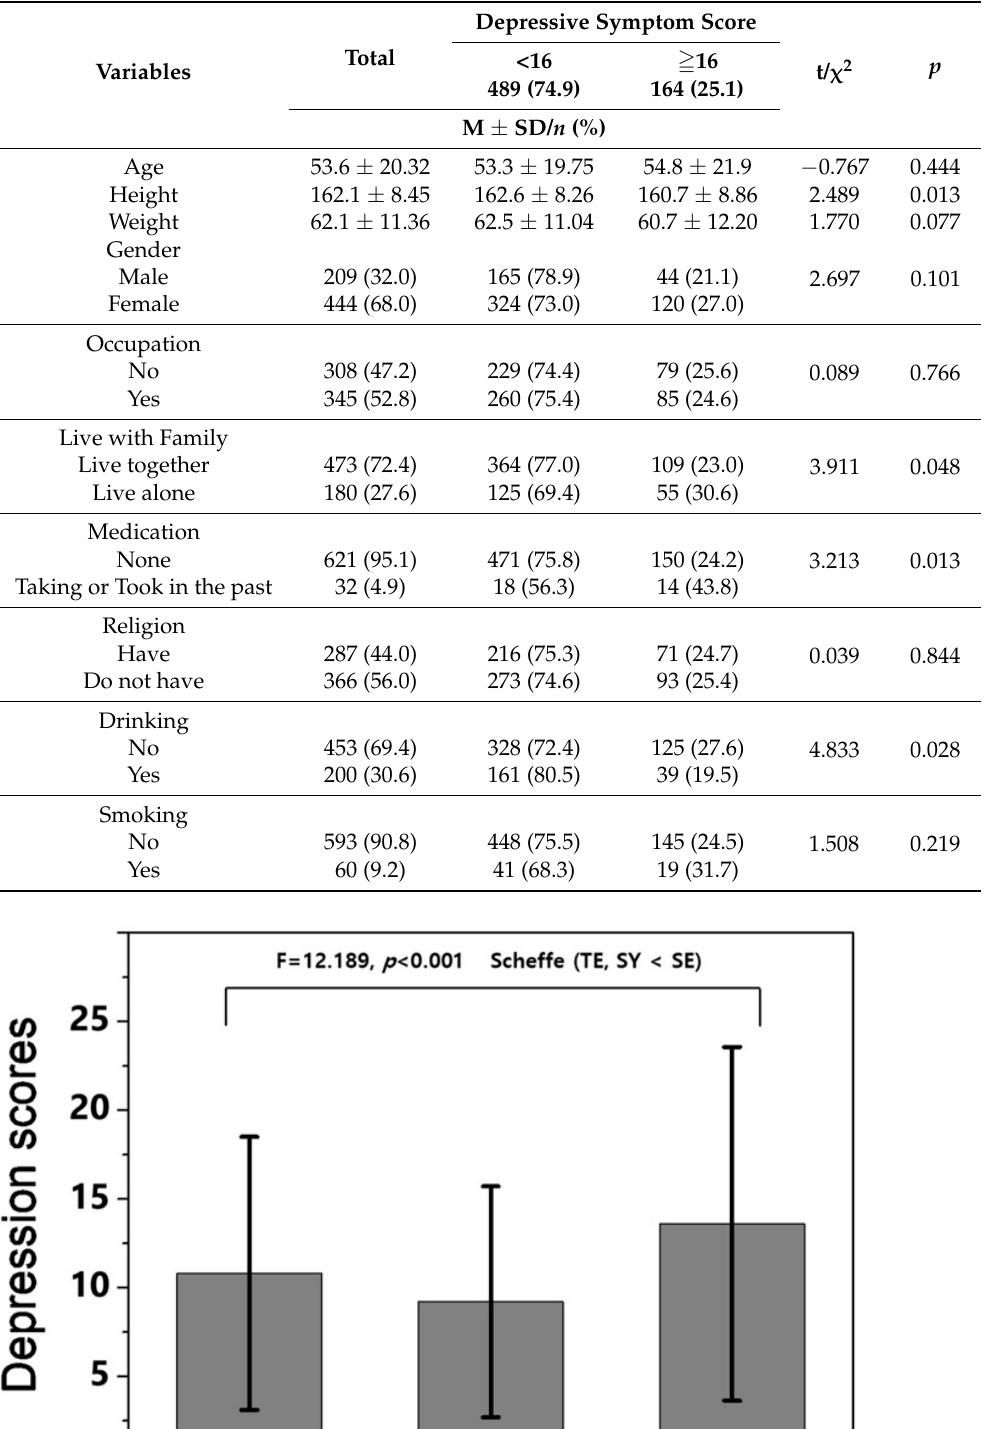
Table 1. General characteristics of the participant according to depressive symptom score ( n = 653).